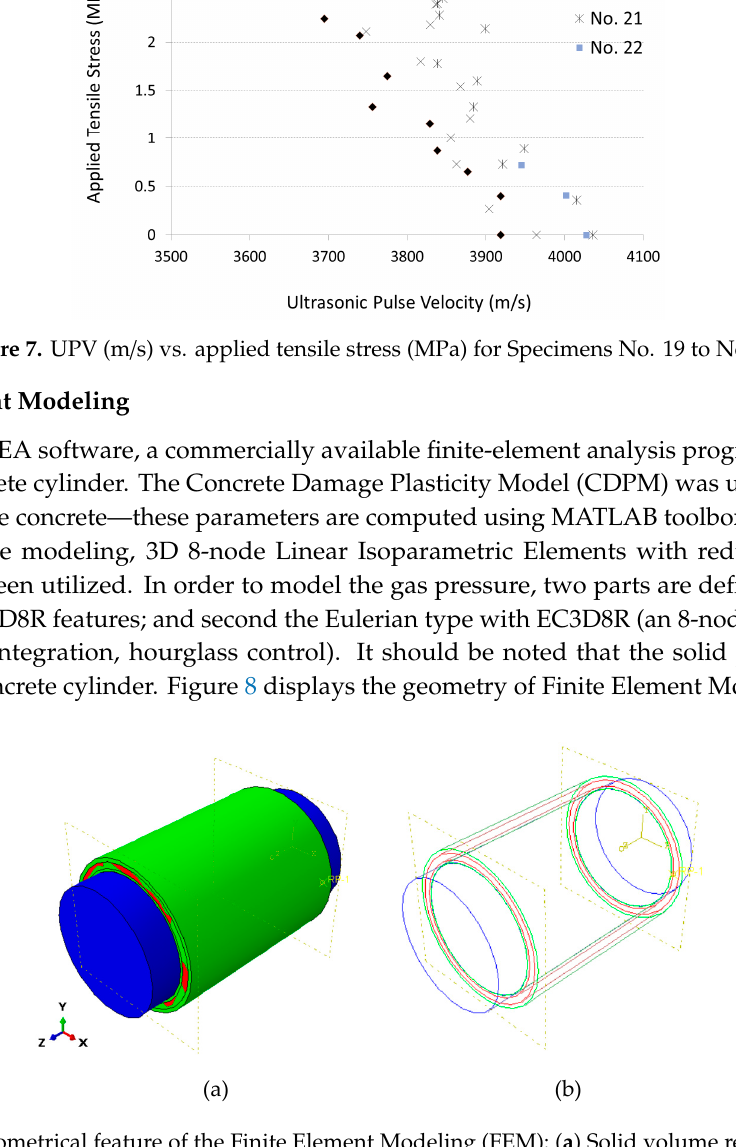
Figure 8. Geometrical feature of the Finite Element Modeling (FEM): ( a ) Solid volume representation; ( b ) Outline representation.